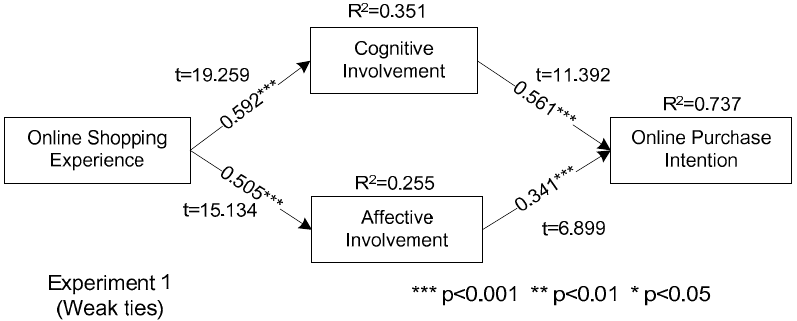
J. Theor. Appl. Electron. Commer. Res. 2020 , 1 , FOR PEER REVIEW Figure 2. Results of structure model analysis (weak ties). Figure 2. Results of structure model analysis (weak ties).